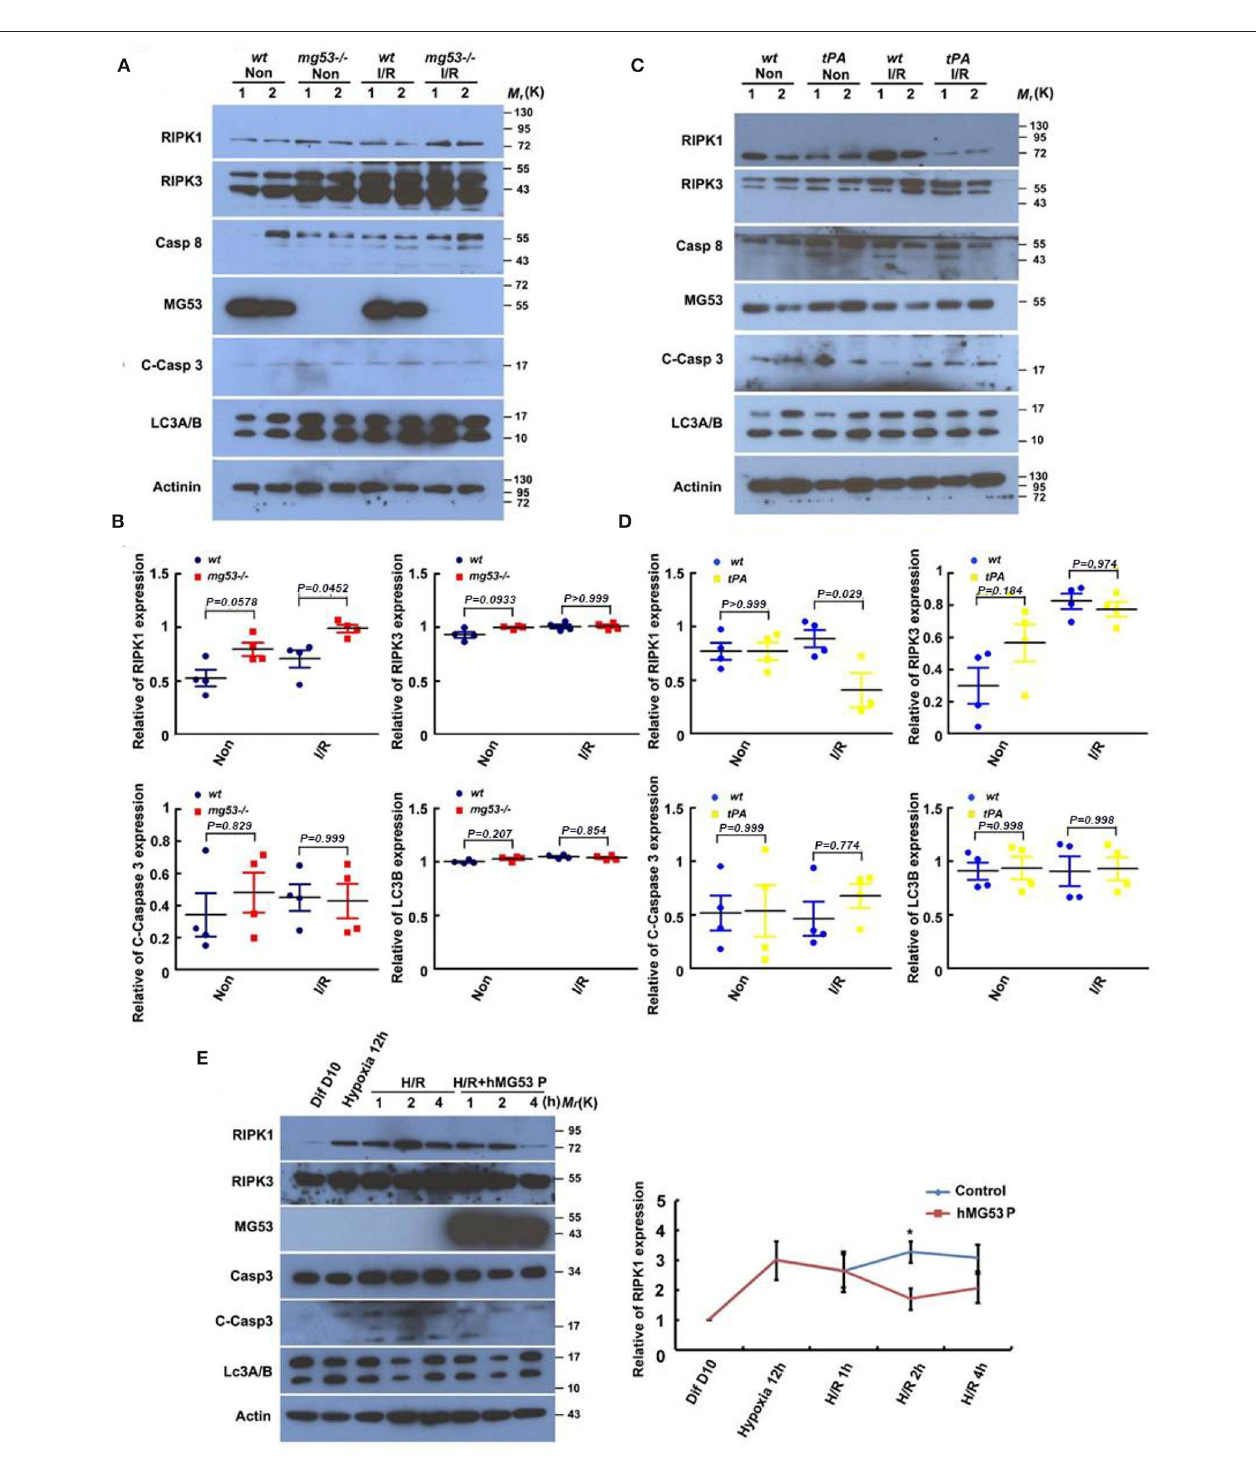
FIGURE 2 | MG53 inhibits necroptosis in cardiac I/R injury via regulating RIPK1. (A) Western blot analysis of RIPK1, RIPK3, and caspase-8 (necroptosis markers), cleaved caspase-3 (apoptosis marker), and LC-3 II (autophagy marker) in infarct (wt I/R and KO I/R) and non-infarct (wt Non and KO Non) areas of wt and mg53–/– hearts. n = 4 per group. (C) The same set of markers was analyzed by western blot in infarct (wt I/R and tPA I/R) and non-infarct (wt Non and tPA Non) areas of wt and tPA-MG53 hearts. n = 4 per group. (B,D) Western blot results were quantified by ImageJ. (E) Representative western blot image of the expression of cell death pathway markers in hiPSC-derived cardiomyocyte at indicated time points of H/R stress with or without rhMG53 protein. n = 3 independent experiments. Diff 10 days: cells at basal condition (10 days after differentiation), Hypoxia 12 h: cells in hypoxia for 12h, H/R 1h (2h, 4h): cells with reperfusion for 1h (2h, 4 h).